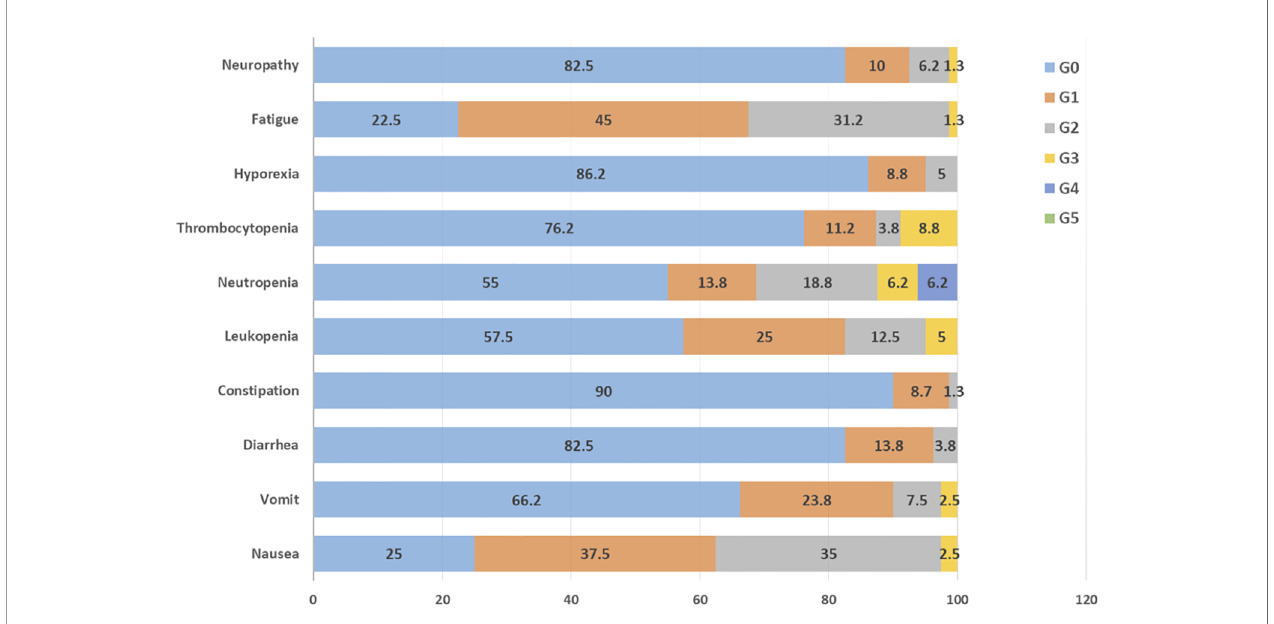
FIGURE 3 | Common toxicities and respective grade (G) seen during treatment with